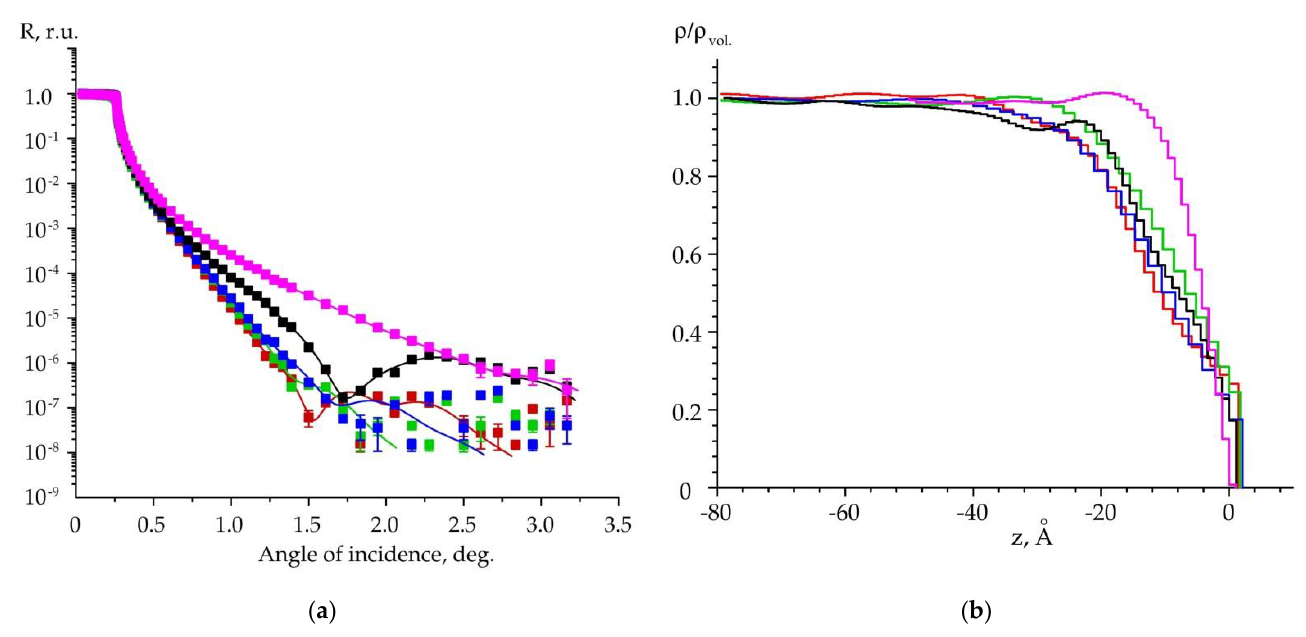
Figure 5. ( a ) Reflectivity curves measured for two samples: original substrate and annealed specimen (1450 °C). The magenta color defines the original substrate. The red, green, blue and black markers represent experimental data along the probing directions, which deviate 0°, −20°, −90° and −110°, respectively, from the AFM scan line in inset of Figure 4. The lines indicate fit results. ( b ) Distributions of depth-graded volumetric density, normalized to the density of bulk SiC, versus depth z .